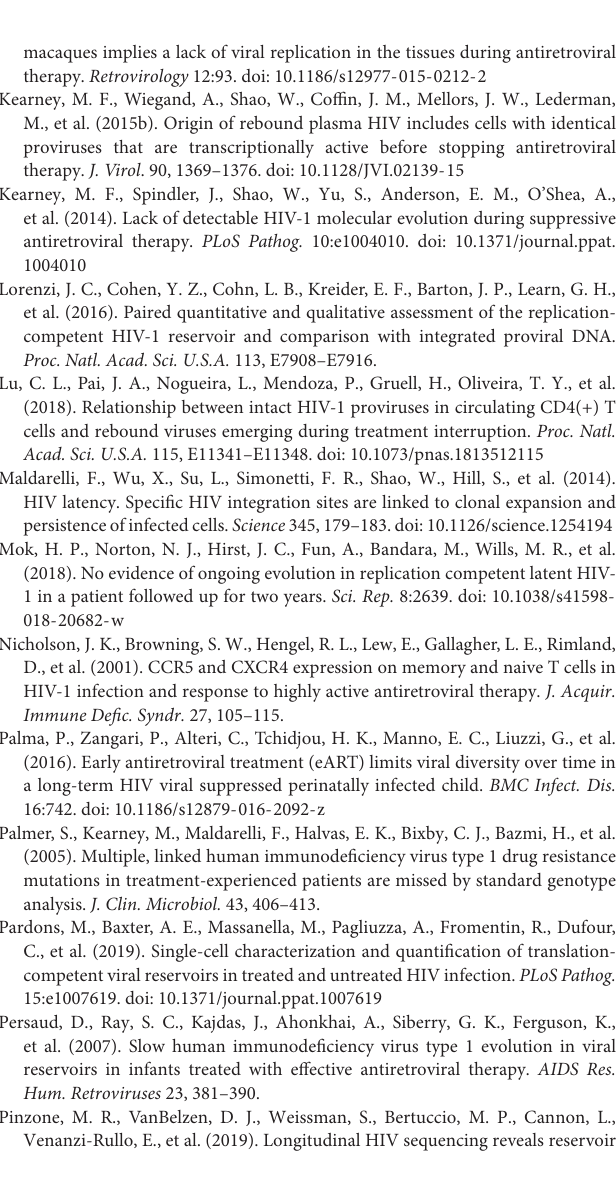
FIGURE S1 | Gating for CD4 T Naïve, CTM, and EM Cell Subsets from PBMC (A) not part of multi-cell conjugates (B) that were viable and stained with the T cell markers CD3 (C) and CD4 (D) but not myeloid cell markers CD14 and CD11c, or lineage markers CD56 and TCR γδ (E) were divided by CD27 and CD45RO staining and collected as T CTM ( F , top-right gate) or T EM ( F , bottom gate) subsets. Cells that were single-positive (T 27 + ; F , top-left gate) for CD27 were further divided by CD57 and CCR7 staining to collect T N (G) subset. Numbers on plots represent percentages of plotted cells falling within the gates shown. Naïve CD4 defined as CD45RO-, CD27 + , CCR7 + , CD57-. CTM CD4 defined as CD45RO + , CD27 + . EM CD4 defined as CD45RO ± , CD27-. FIGURE S2 | NJ distance tree of drug-resistant sequences from longitudinal samples from Patient 1. The tree show that drug resistance mutations emerged years prior to virologic failure. ∗ Bootstrap values >